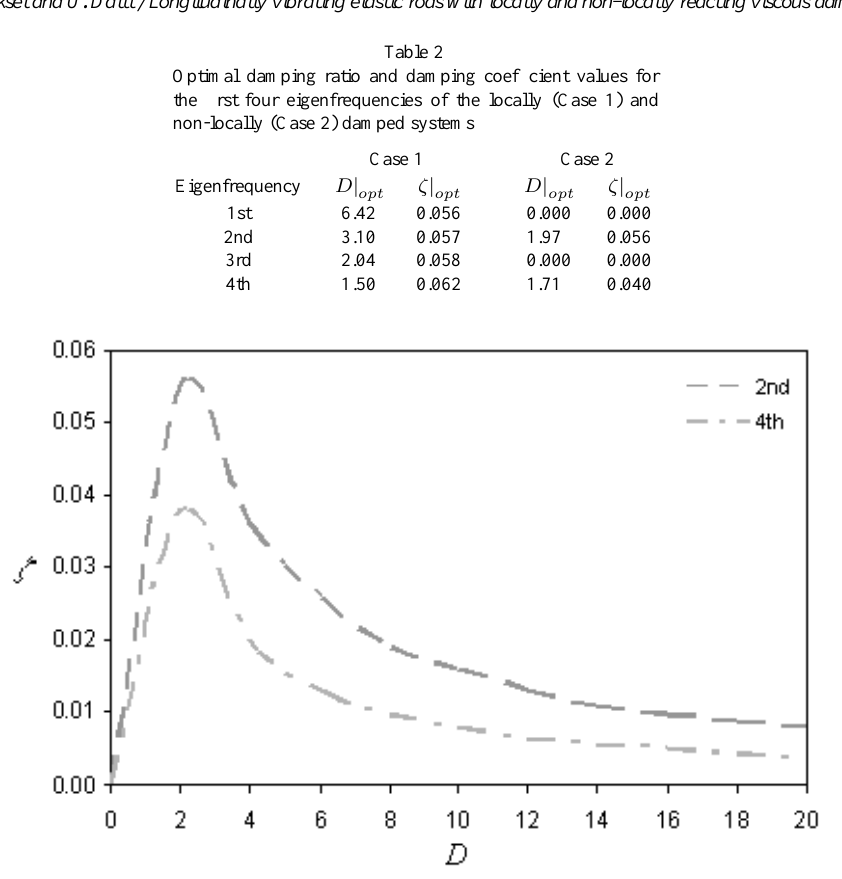
Table 2 Optimal damping ratio and damping coefficient values for